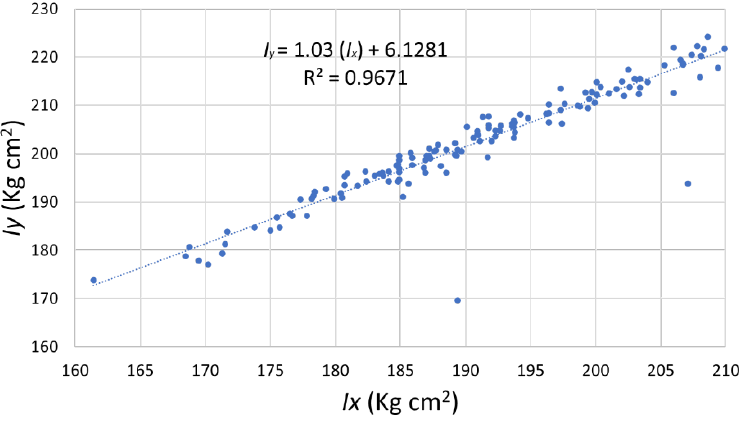
Figure 16. Moment of inertia I y as a function of the moment of inertia I x